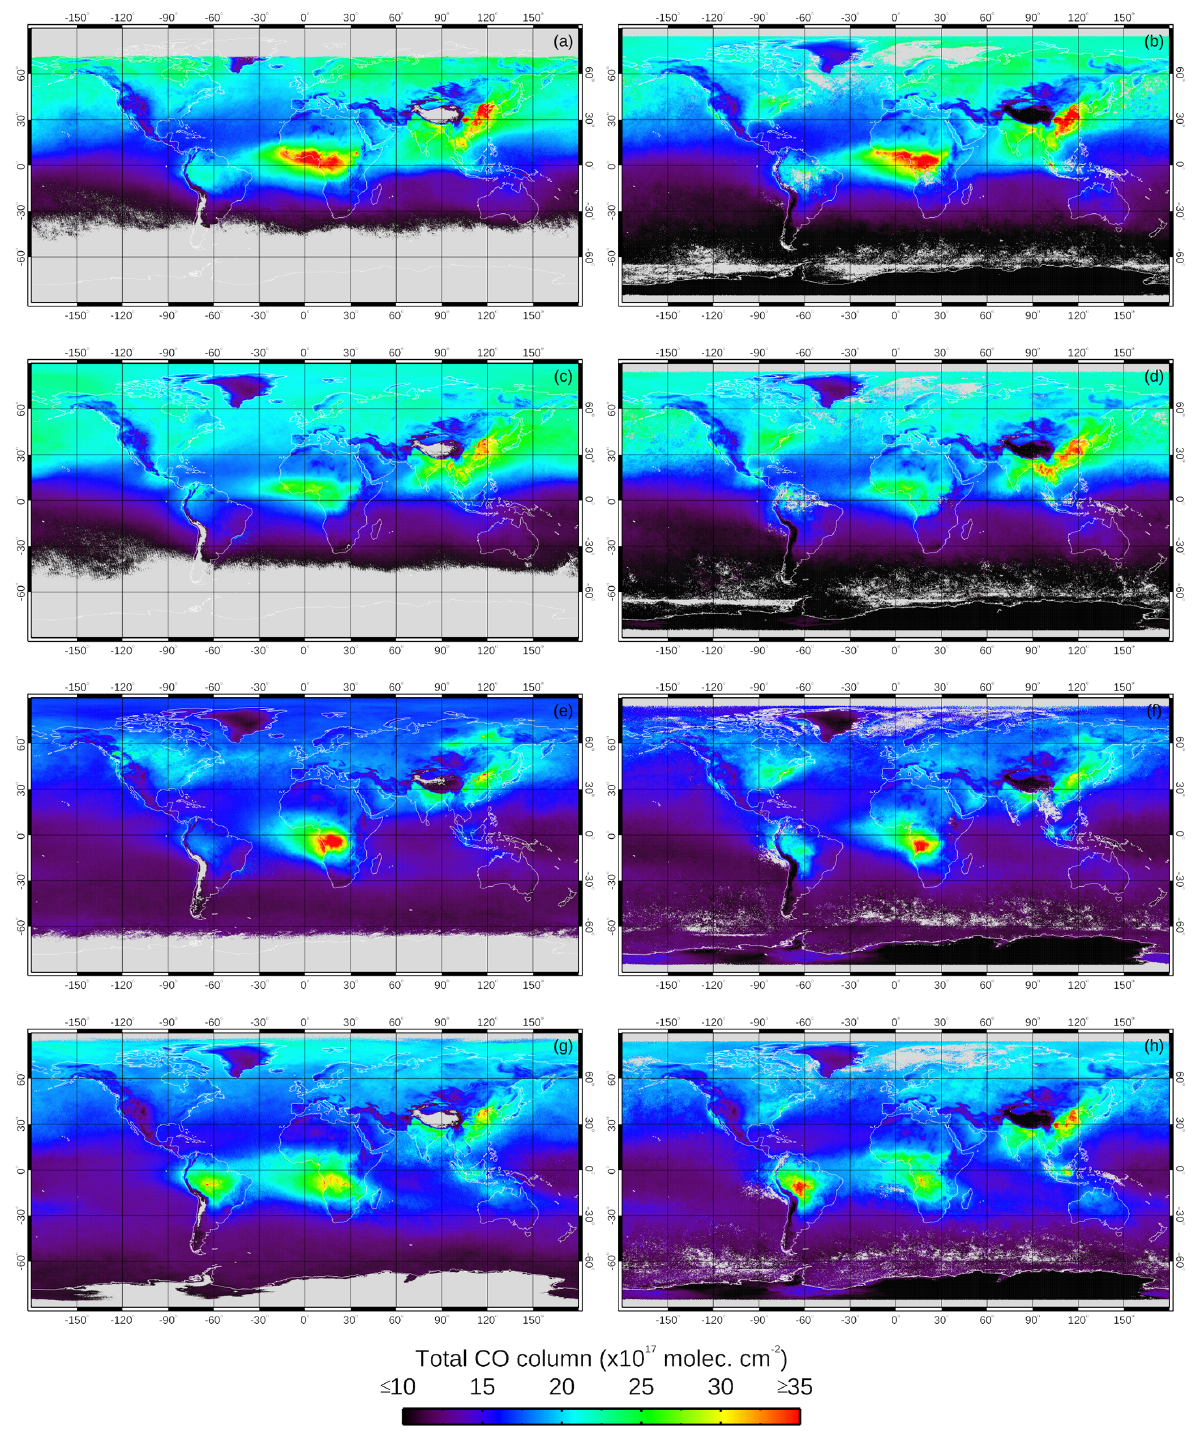
Figure 11. Seasonal averages of TROPOMI and MOPITT TIR CO retrievals. (a) December 2017 to February 2018 (DJF) TROPOMI mean. (b) Same for MOPITT. (c) March–May 2018 (MAM) TROPOMI mean. (d) Same for MOPITT. (e) June–August 2018 (JJA) TROPOMI mean. (f) Same for MOPITT. (g) September–November 2018 (SON) TROPOMI mean. (h) Same for MOPITT. Sharp discontinuities visible in some panels at 65 ◦ S are due to differences in the definition of the MOPITT cloud mask poleward of latitude 65 ◦